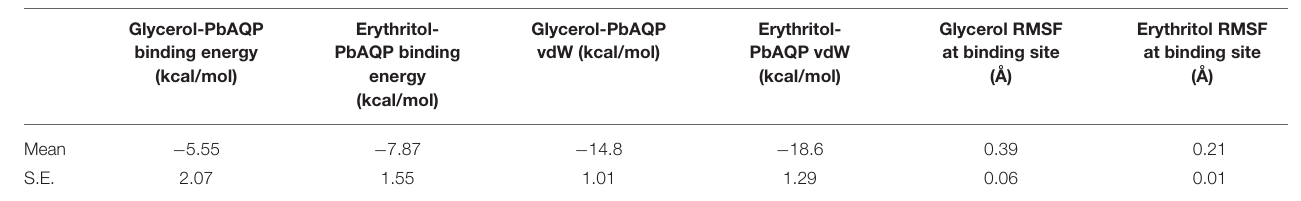
TABLE 1 | Glycerol-PbAQP and Erythritol-PbAQP